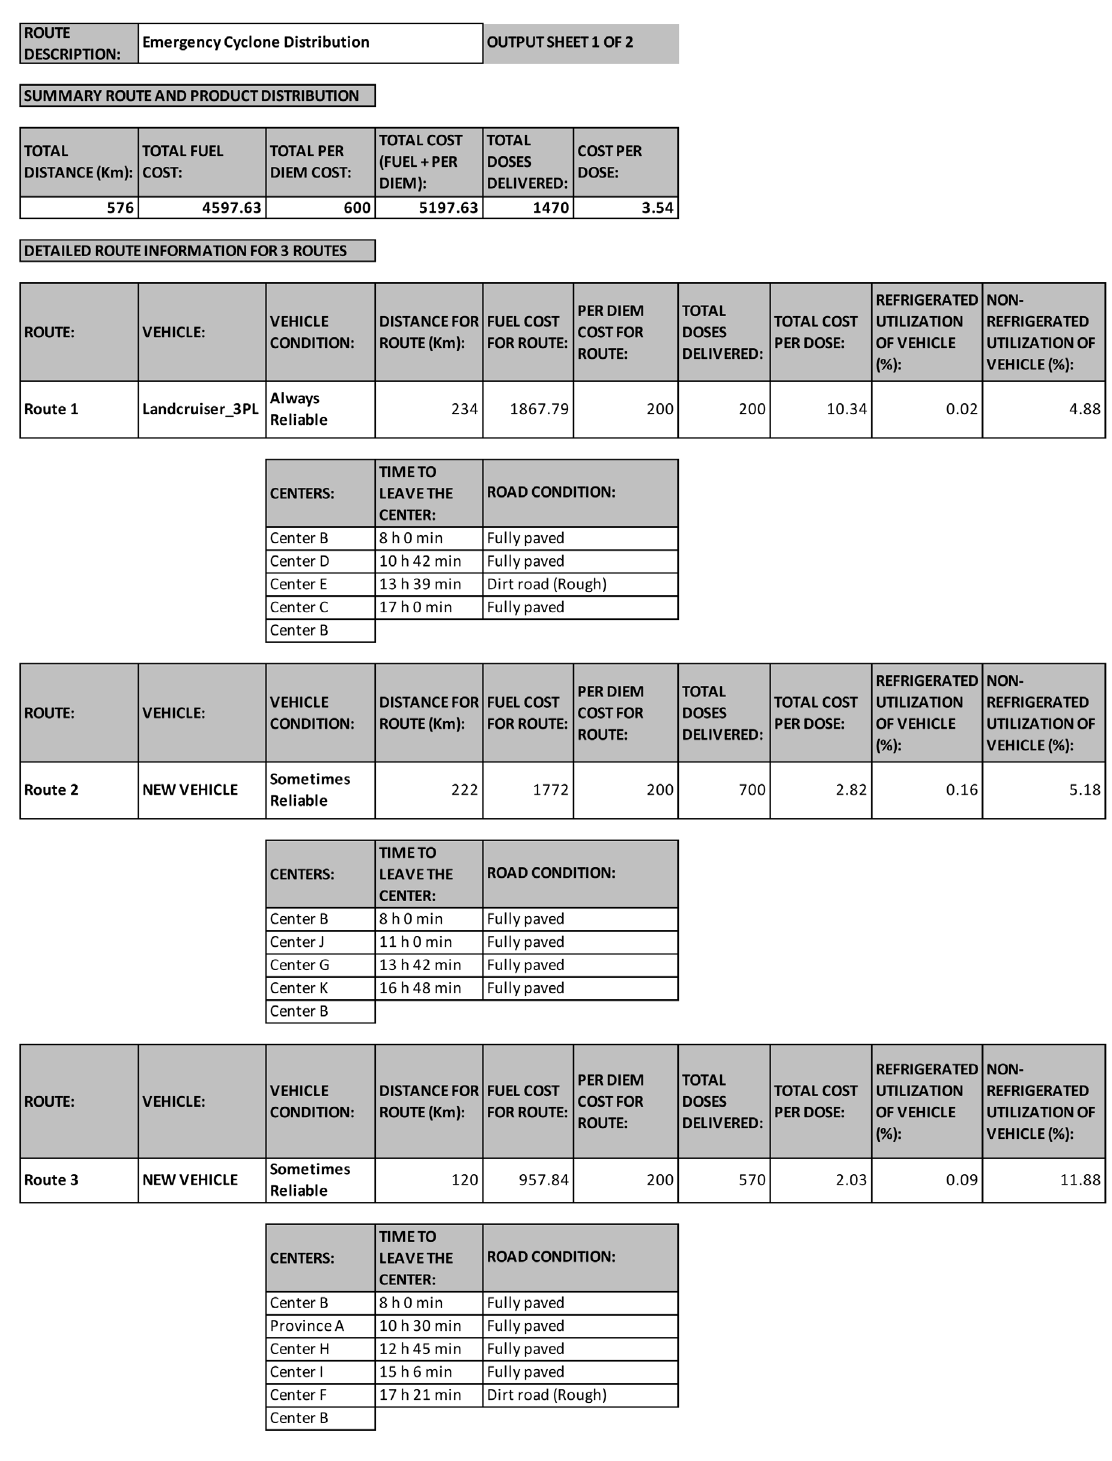
Figure 7. New routes for emergency cyclone distribution with two available vehicles.